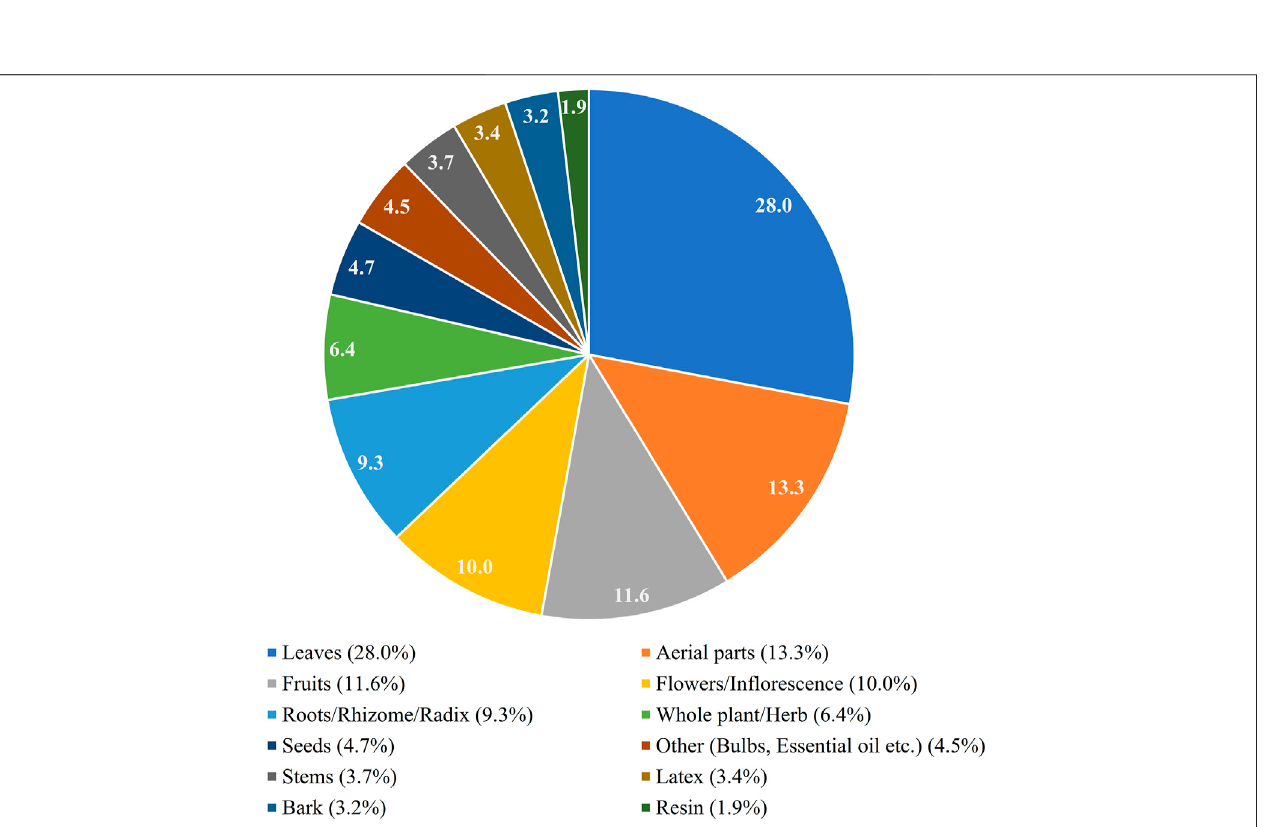
FIGURE 4 | Most cited plant parts in relation to skin ailment reports.